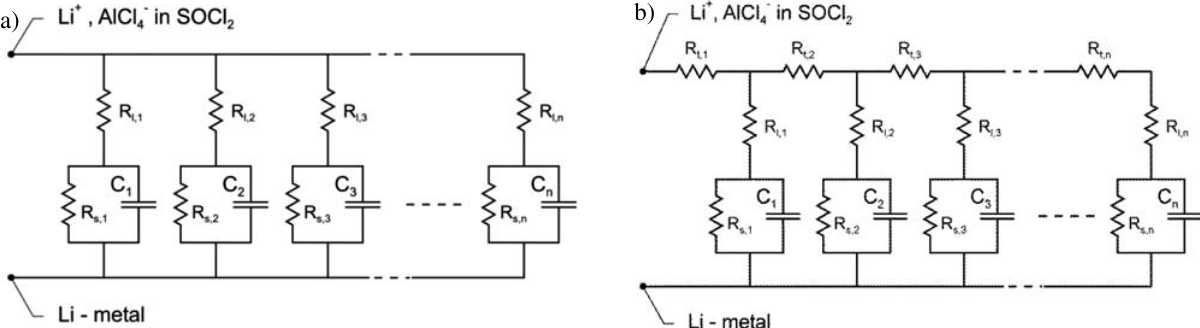
Figure 9. Electrical circuits tested as models of the LiCl layer. Fig. 9a is simulating the »simple crack« model of Fig. 8a, and 9b is another »ladder« type of circuit. which may respond as a CPA over certain frequency ranges dependent on the actual values of resistances and capacitances. Even hig- her degrees of branching are necessary in order to simulate the observed CPE behaviour pointing to a much branched crack and tunnel